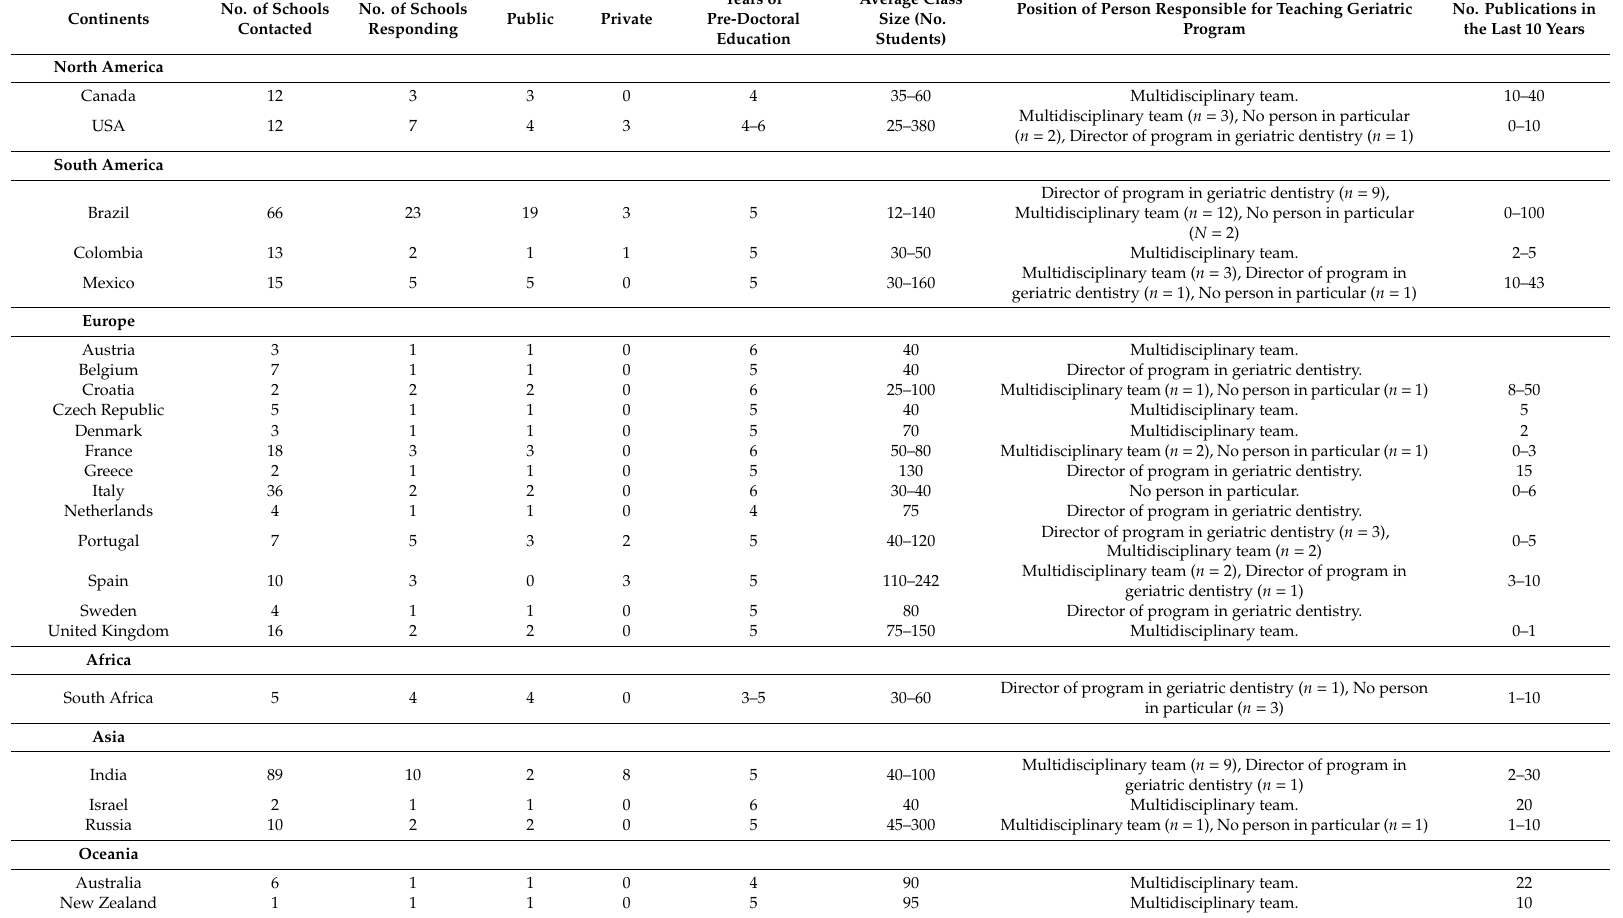
Table 1. List of the number of schools by country participating in the survey.